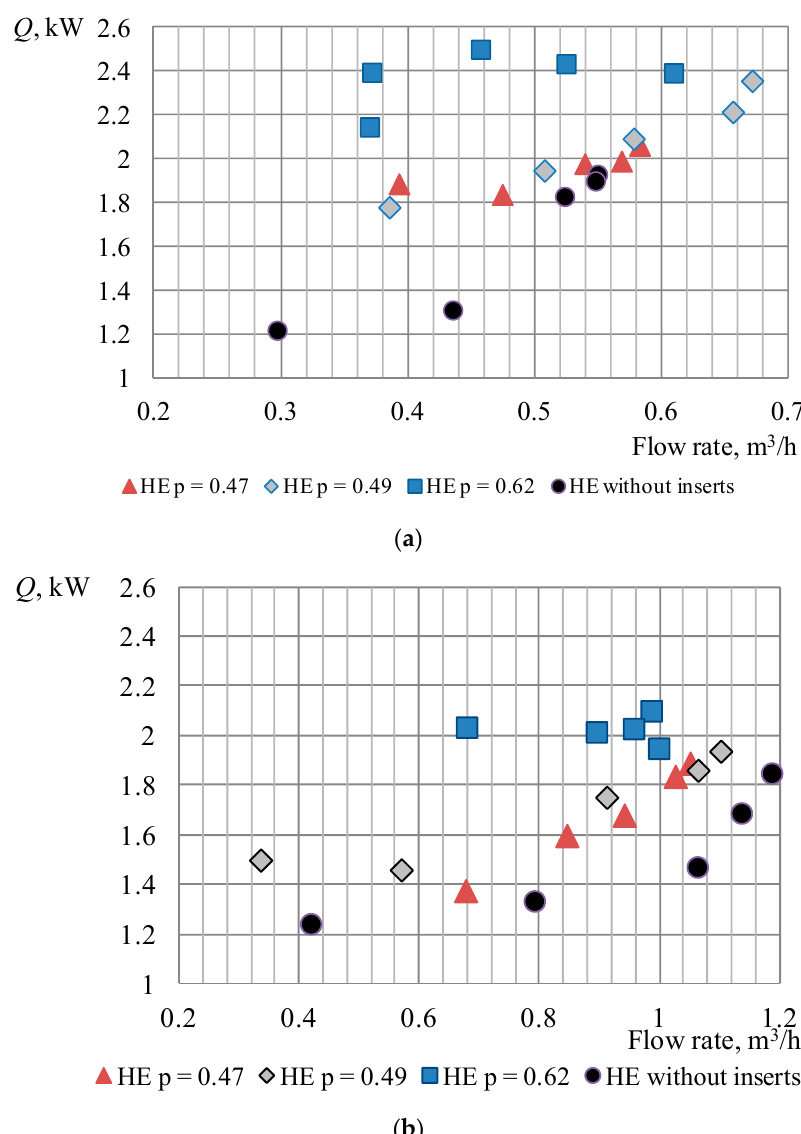
Figure 3. Thermal power of heat exchangers at different operation modes of water supply system: ( a ) the first operation mode; ( b ) the second operation mode.